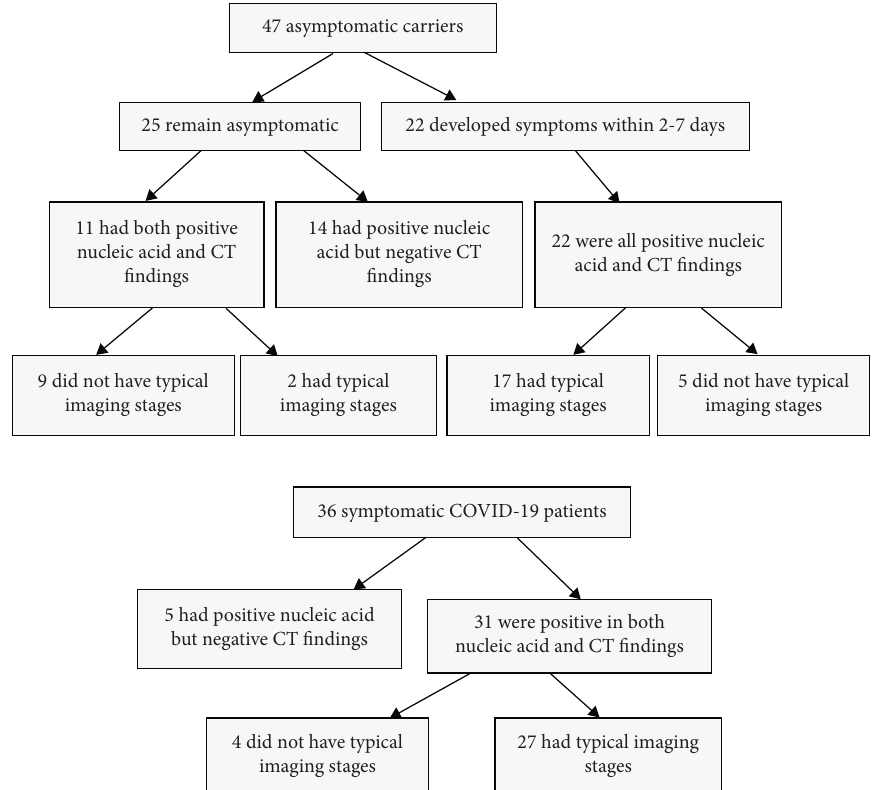
Figure 1: Te evolution of the situation of asymptomatic carriers and symptomatic COVID-19